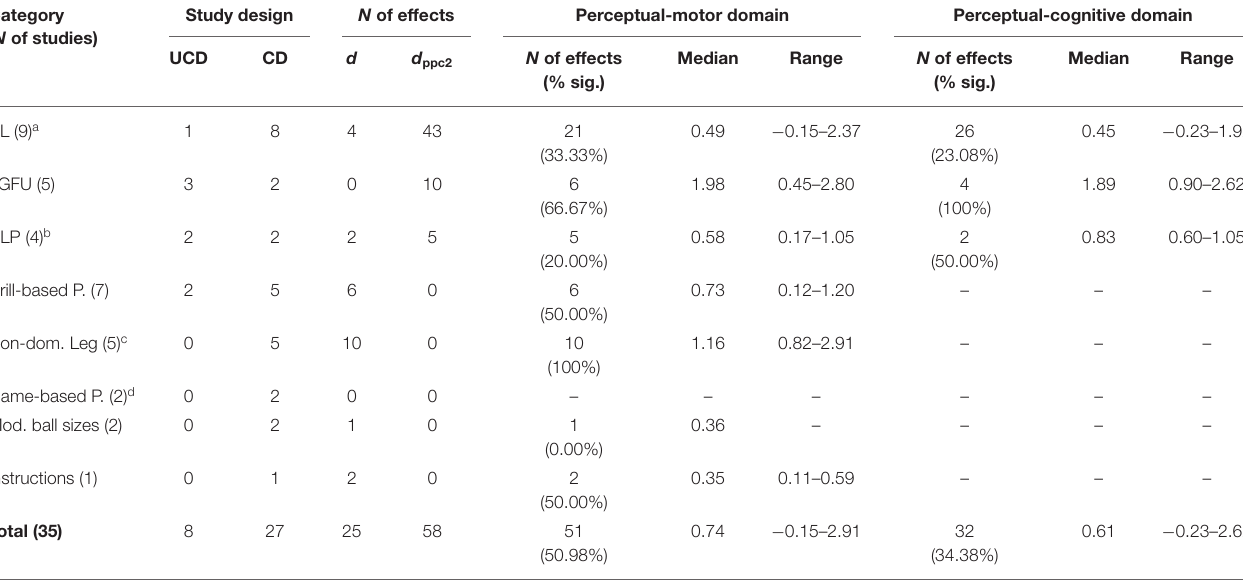
TABLE 6 | Recalculated effect sizes for perceptual-motor and perceptual-cognitive outcomes from controlled